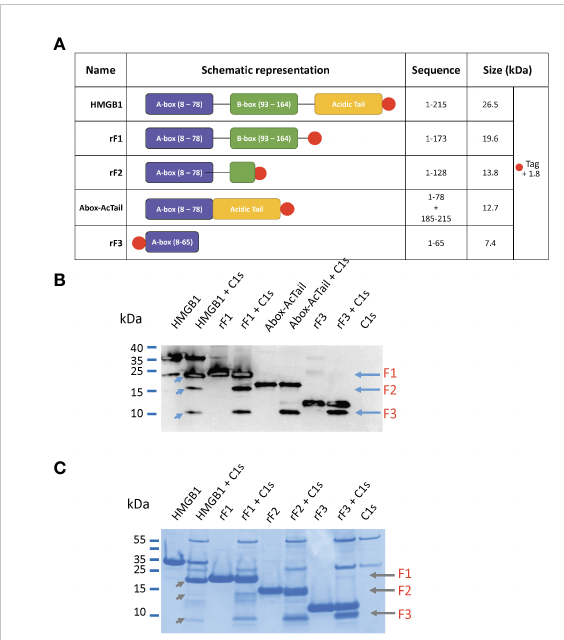
FIGURE 7 HMGB1 variants and their digestion by C1s. (A) List of the HMGB1 constructs used in this experiment with their corresponding sequence and molecular weight. The N- or C-terminal His-tag is shown with a red dot. (B) Western blot of HMGB1 and fragments incubated or not with C1s (at 10%) for 5 hours at 37°C using an N- terminal anti-HMGB1 antibody targeting the sequence 2 – 17 (as in Figure 3). The fragments loaded are: HMGB1, rF1(1-K173), Abox- AcTail, rF3(1-K65). The three fragments F1 - F3 can be found after digestion of HMGB1 (left blue arrows). F2 and F3 are present after rF1 cleavage and F3 only after cleavage of Abox-AcTail and rF3. Redundant fragment identi fi cation (as in Figure 4) was obtained using LC/ESI analyses performed on liquid mix of C1s with rF1, Abox-AcTail and rF3. This WB experiment was performed three times. (C) Same experiment as above analyzed by tricine gels, using rF2 instead of the Abox-AcTail.